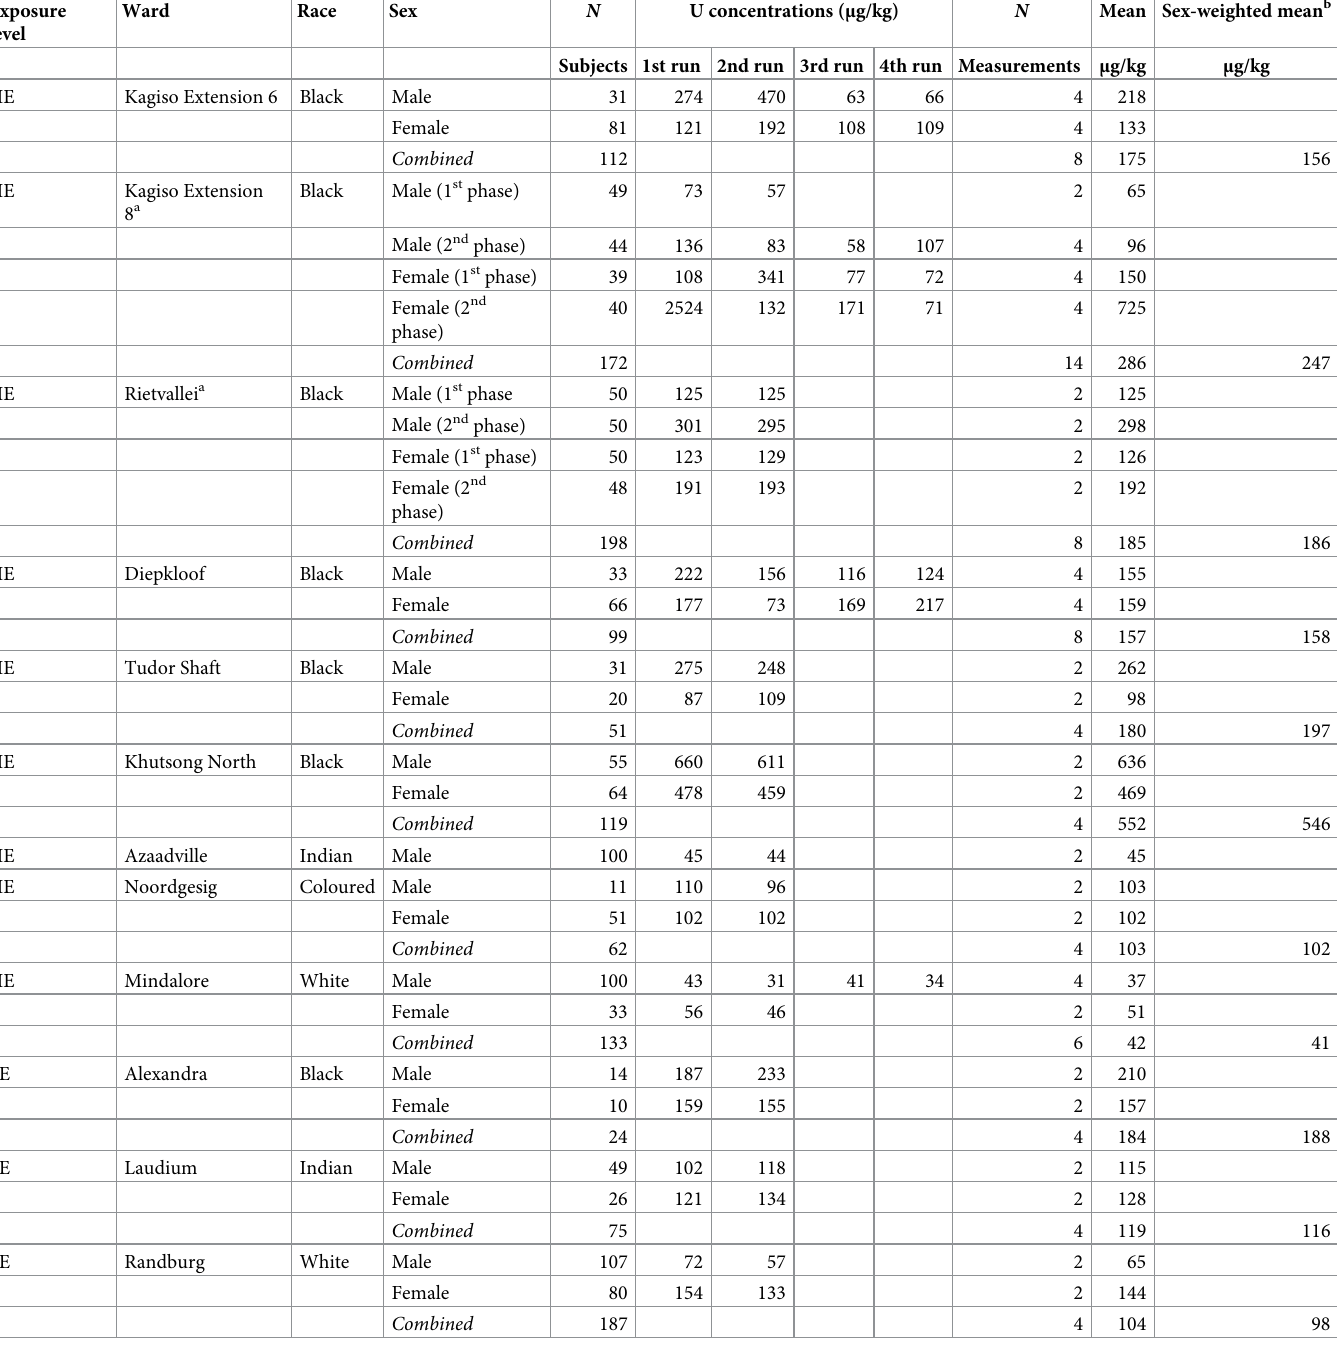
Table 1. Uranium concentration in human scalp hair of 70 measurements in 27 composite hair samples of 1332 individuals from 12 selected wards in Gauteng Province, South Africa. Exposure